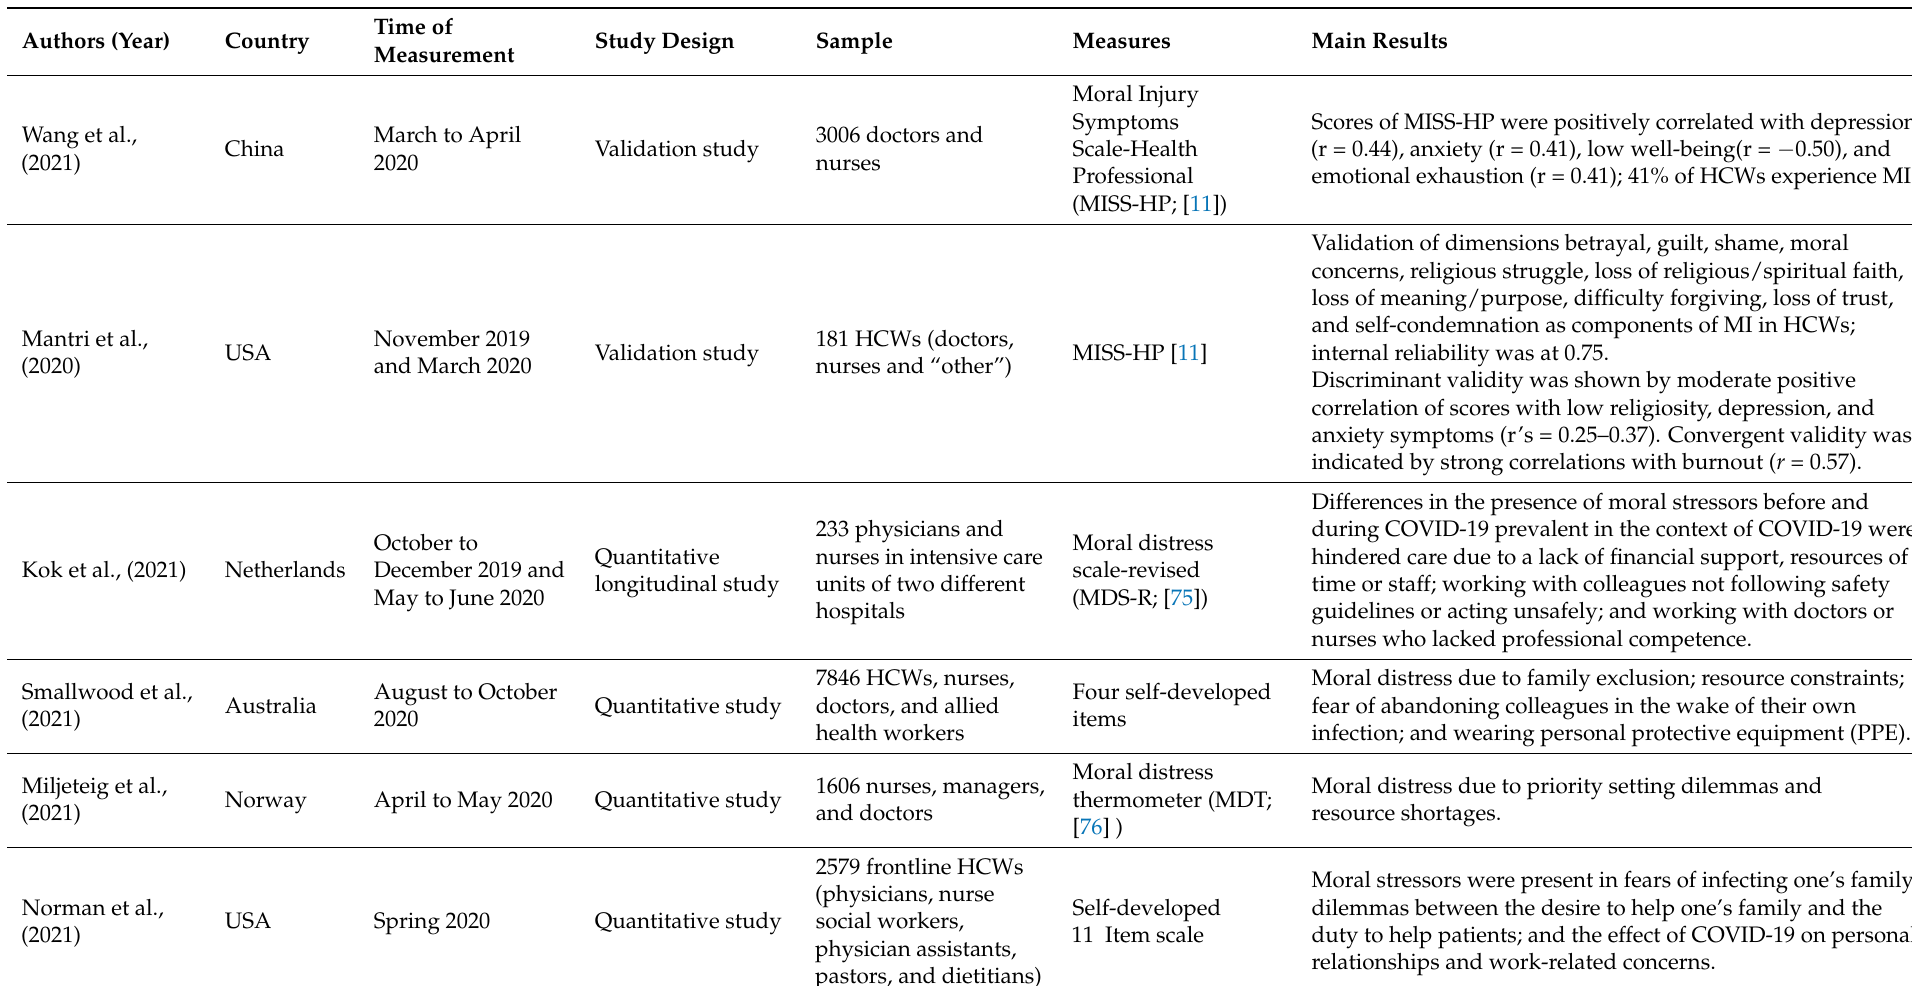
Table 1. Summary of